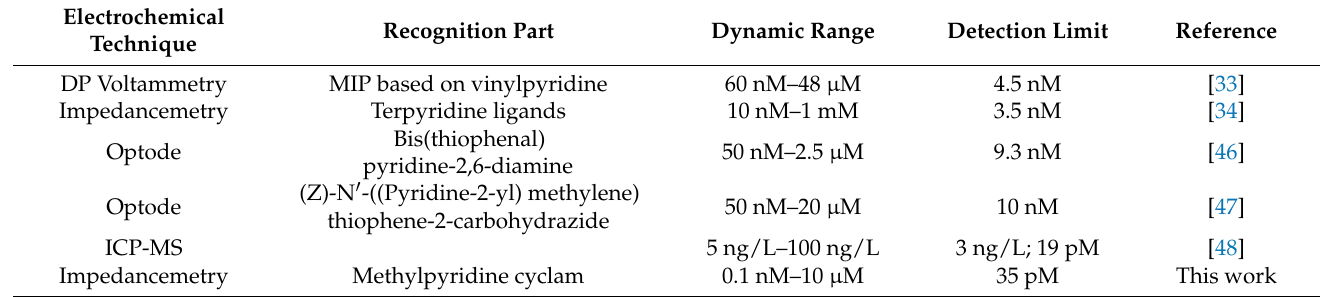
Table 4. Comparison of the analytical performance of the bis-N-MPyC functionalized gold electrode with that of the previously published electrochemical sensors for